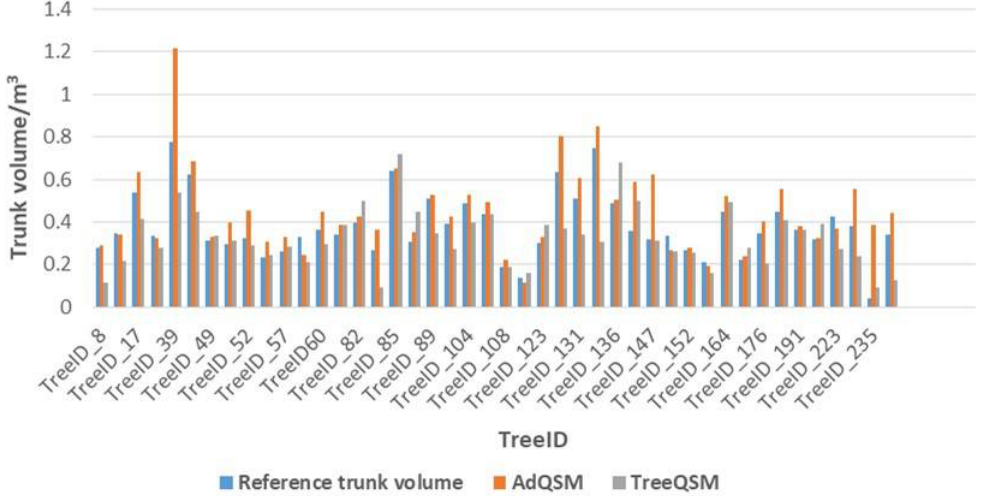
Figure 14. The reference value based on the allometric equation and QSM estimates for each tree.